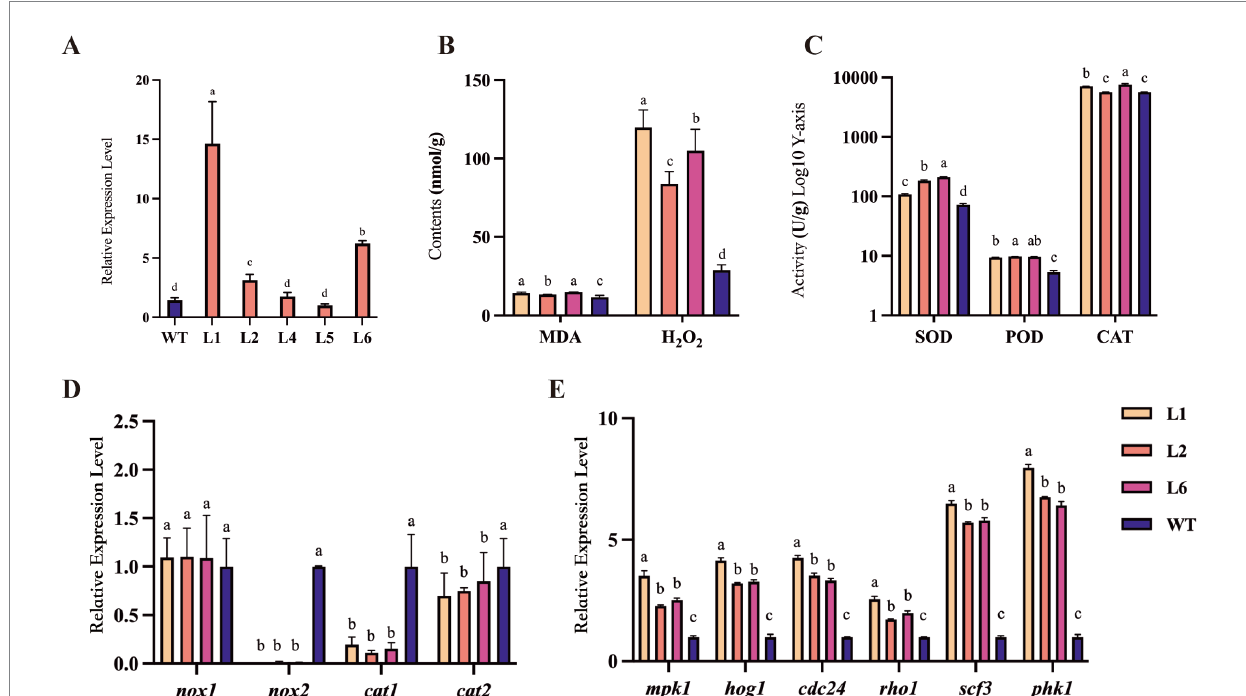
FIGURE 2 The changes of antioxidant enzyme activities in Polec2 overexpressing strains. (A) Relative expressions of Polec2 in the six transformants (L1 to L6) after grown on complete medium without hygromycin for five rounds of cultivation. (B) Change in malondialdehyde (MDA) and hydrogen peroxide (H 2 O 2 ) contents. (C) Change in superoxide dismutase (SOD), peroxidase (POD), and catalase (CAT) activities. (D) Expression analysis of genes in the reactive oxygen species (ROS) metabolism, including the NADPH oxidases catalytic subunits genes nox1 and nox2 , and the catalase genes cat1 and cat2 . (E) Expression analysis of genes in the mitogen-activated protein kinases (MAPK) signaling pathway, including MAPKs genes hog1 and mpk1 , serine/ threonine-protein kinases Pkh1 , and guanine nucleotide exchange factors pho1 , scf3 , and cdc24 . Letters indicate significant differences from the WT strain ( p < 0.05, Waller-Duncan